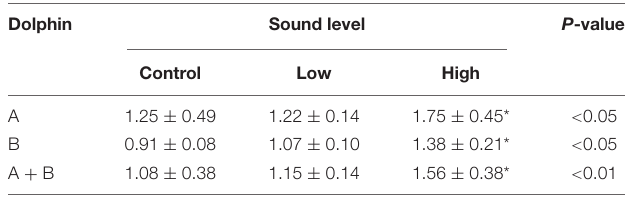
TABLE 2 | Results of Kruskal-Wallis tests with post-hoc tests of cortisol concentration ratio (mean ± SD) of post/pre-exposure samples.